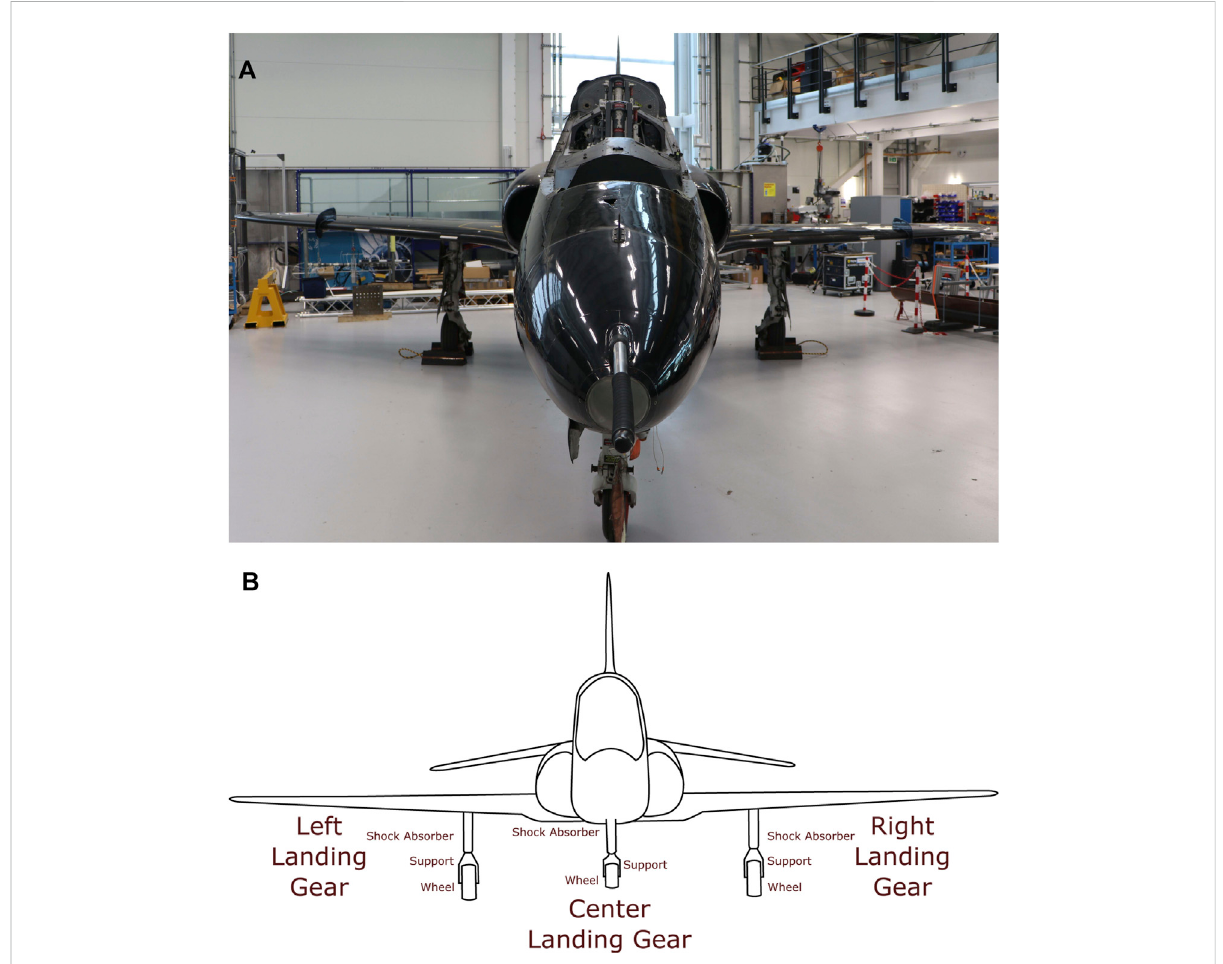
FIGURE 5 (A) Photoofthefront viewoftheHawkT.Mk1attheLaboratoryforVeri fi cationandValidation. (B) IrreducibleElement modelbreakdownofthe landing gear of the Hawk T.